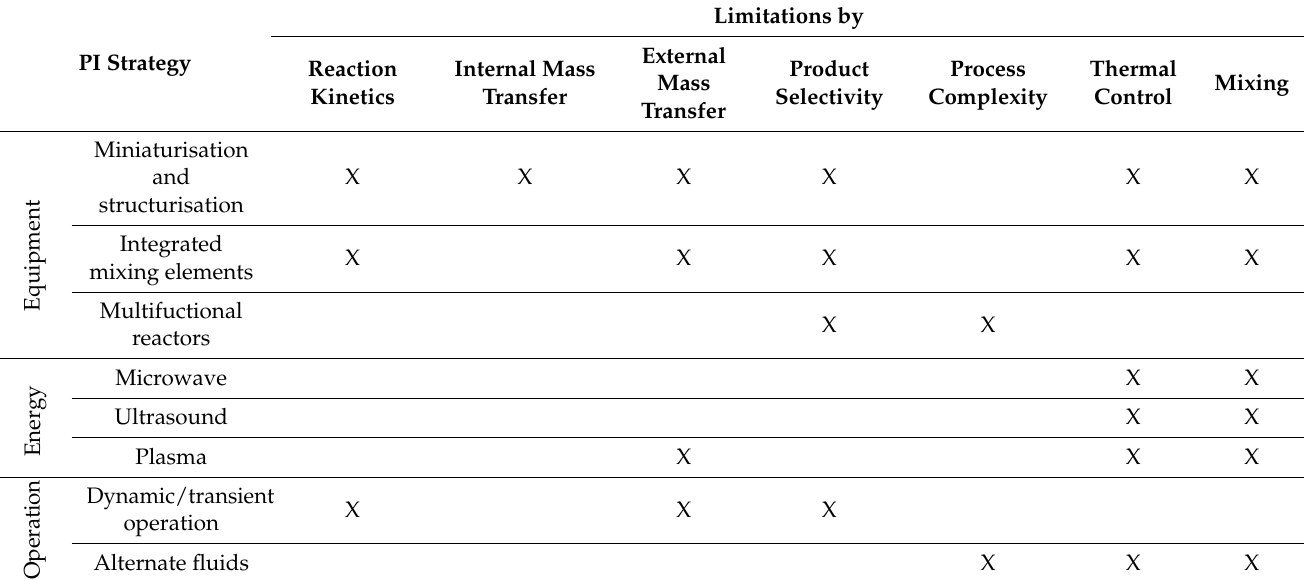
Table 2. Commonly-encountered process limitations and suitability of different PI